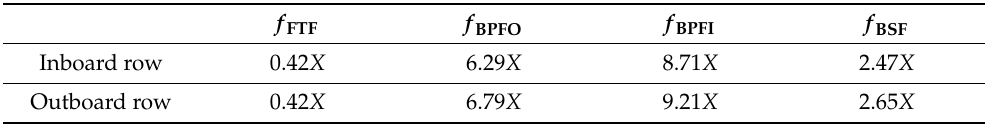
Table 3. Characteristic frequencies (defect frequencies) of the wheel bearing ( X is the rotating fre- quency).